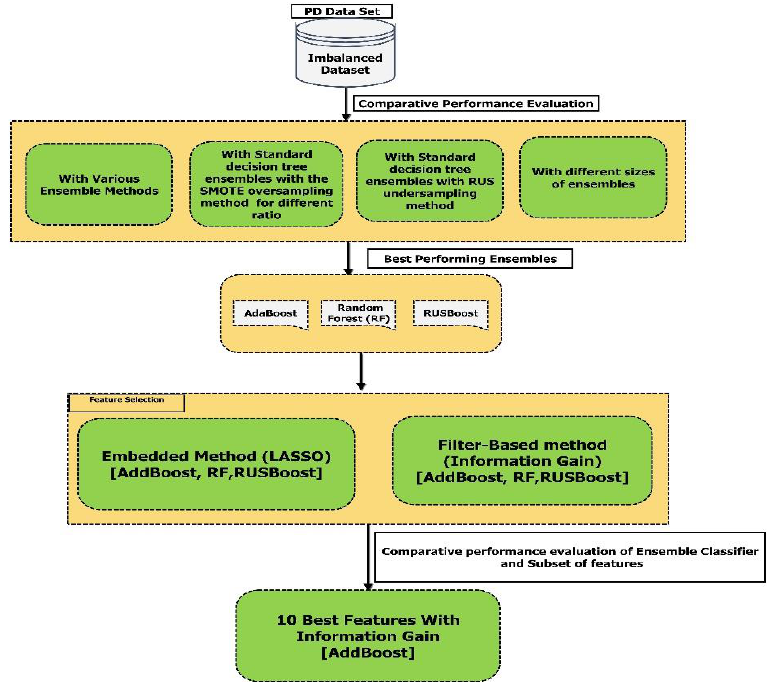
Figure 1. The methodology implemented in this research for comparative performance evaluation of ensemble classifiers (oversampling, undersampling), feature selection, model building.